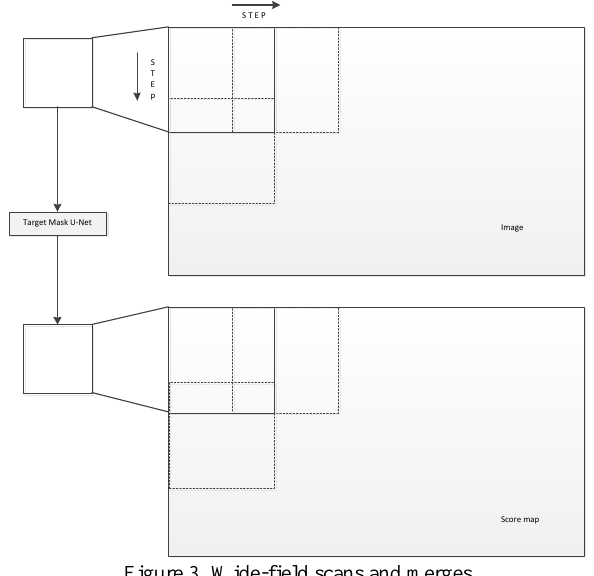
Figure 3. Wide-field scans and merges